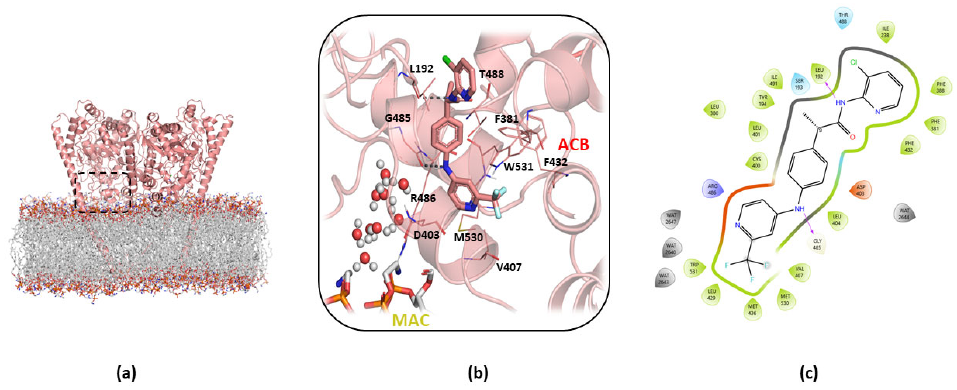
Figure 5. Details of cluster b0 of the A2db1 binding mode of TPA14 in monomer B of m FAAH after 150 ns of MDs. ( a ) Global overview of the TPA14 binding site, indicated by the black dashed rectangle. ( b ) Zoom view of TPA14 (pink stick) cluster b0 of the A2db1 binding mode and its interactions with the surrounding key residues. ( c ) TPA14 2D interaction diagram obtained with Maestro GUI. The magenta arrow indicates the H-bond